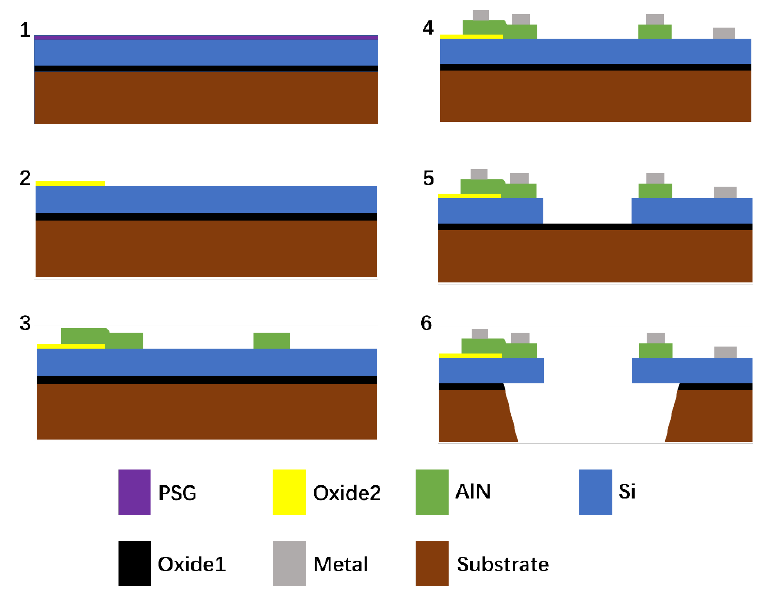
Figure 4. Schematic of the device fabrication process. Table 1. Parameters of the fabrication